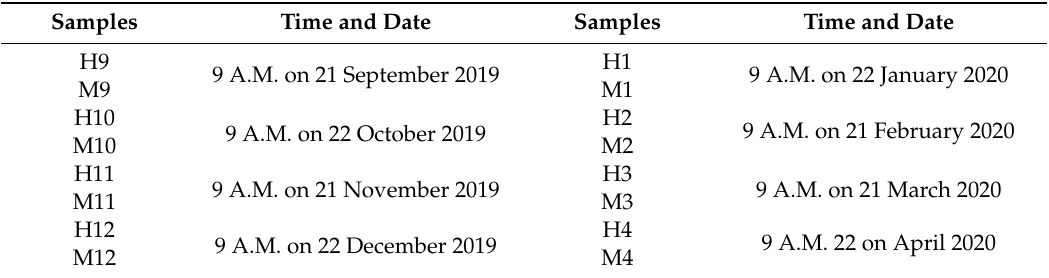
Table 1. Sample collection time and